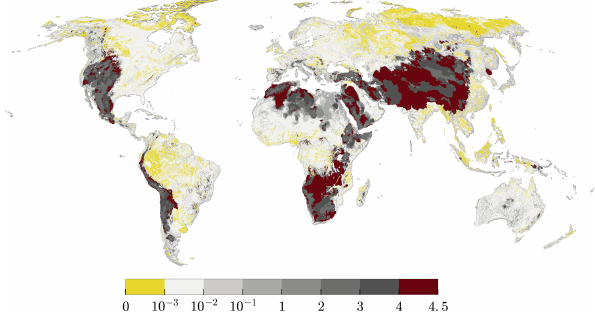
Figure 5. Uncertainty in h caused by variability in hydraulic con- ductivity data between GLHYMPS 1.0 and 2.0 (dominant in brown to green) in relation to uncertainty in h caused by variability in pa- rameters based on Monte Carlo simulations (dominant in blue to | h 1 − h 2 | light blue) calculated as , where h 1 / 2 is the simulated head IQR (h mc ) based on GLHMYPS 1.0 and 2.0 and h mc the simulated head of all Monte Carlo